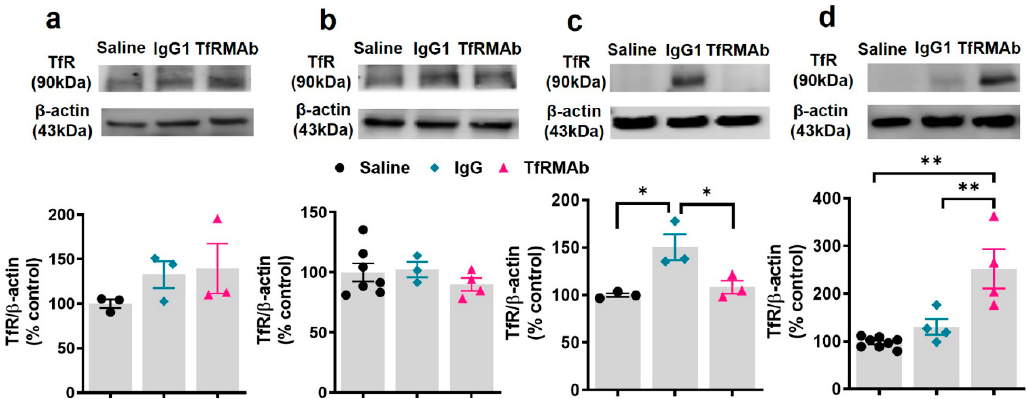
Figure 6. Transferrin receptor (TfR) protein levels following acute and chronic dosing of the high- affinity bivalent TfRMAb in mice. Mice were treated with a single 3 mg/kg SQ dose or three days per week for four weeks with a 3 mg/kg SQ dose of TfRMAb, and brain ( a , b ) and spleen ( c , d ) TfR protein levels were measured. Whole brain tissue TfR protein after 24 h ( a ) and chronic ( b ) TfRMAb dosing. Spleen TfR protein after 24 h ( c ) and chronic ( d ) TfRMAb dosing. TfR levels were detected by Western blotting using a non-competing antibody against the TfR. Data are shown as the mean ± SEM of n = 3–8 per group. * p < 0.05, ** p < 0.01.